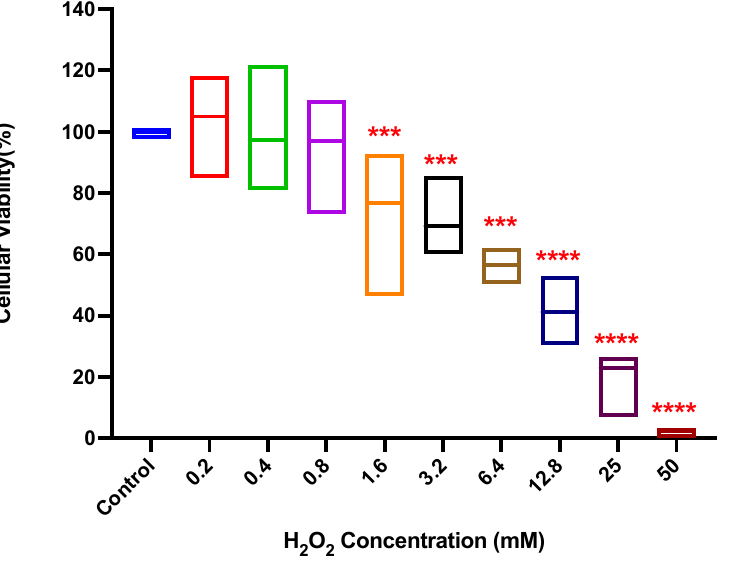
Figure 1. Cell viability of HUVECs treated with H 2 O 2 . The cells were exposed to different concentra- tions of H 2 O 2 for 12 h and then the cell viability was measured by MTS assay. Data are presented as the mean ± standard deviation of the results obtained in independent experiments. Statistically significant differences are indicated compared to controls (*** = p < 0.001; **** = p < 0.0001; n = 3).